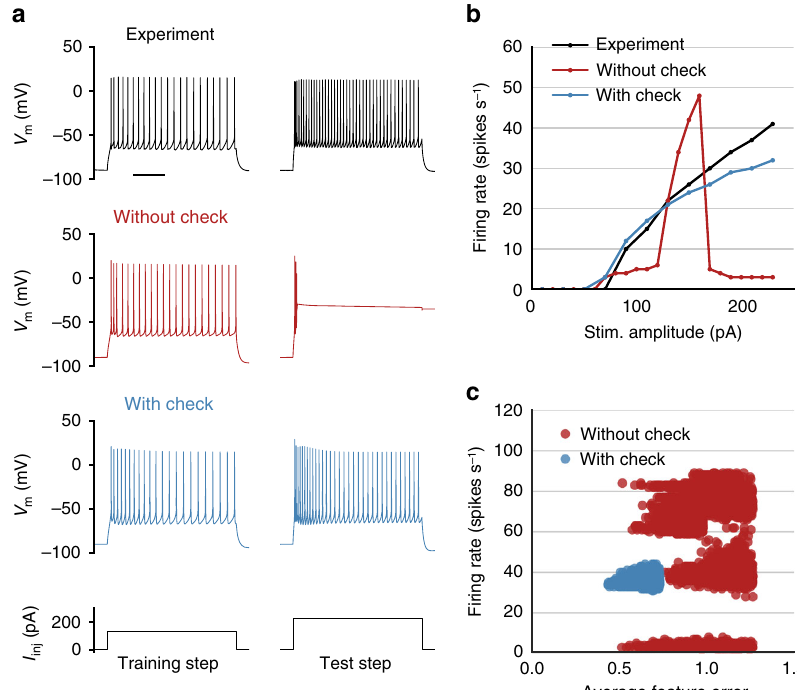
Fig. 4 Addressing depolarization block during optimization. The same example cell is shown in a – c . a Voltage responses to step current injections of two amplitudes (left: 130 pA, right: 230 pA) from the original experiment (top), a best- fi t model without an on-line penalty for depolarization block (middle), and a best- fi t model with an on-line penalty for depolarization block (bottom); scale bar, 250 ms. b Firing rates measured in the experiment (black), by the model without a penalty (red), and by the model with a penalty (blue) in response to a range of step current injections. Note the drop in fi ring rate in the red trace after 170 pA due to the onset of depolarization block. c Firing rates elicited by a high (240 pA) current step from all 1200 models generated by the genetic algorithm at the end of optimization for the example cell compared to the average feature error of each model. Red points are the models generated without a depolarization block penalty, and blue points are models generated with a depolarization block